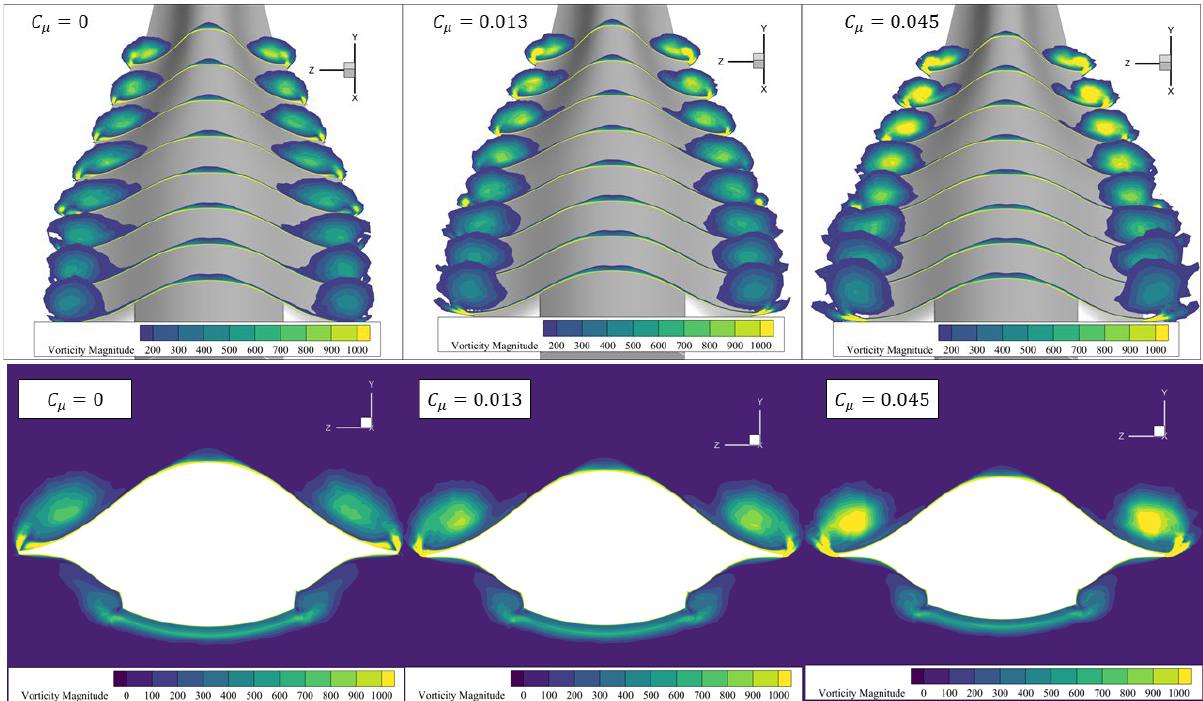
Figure 19. Comparison of the vorticity contours for different jet momentum coefficients at α = 10 ◦ , x / L 0 = 0.6.